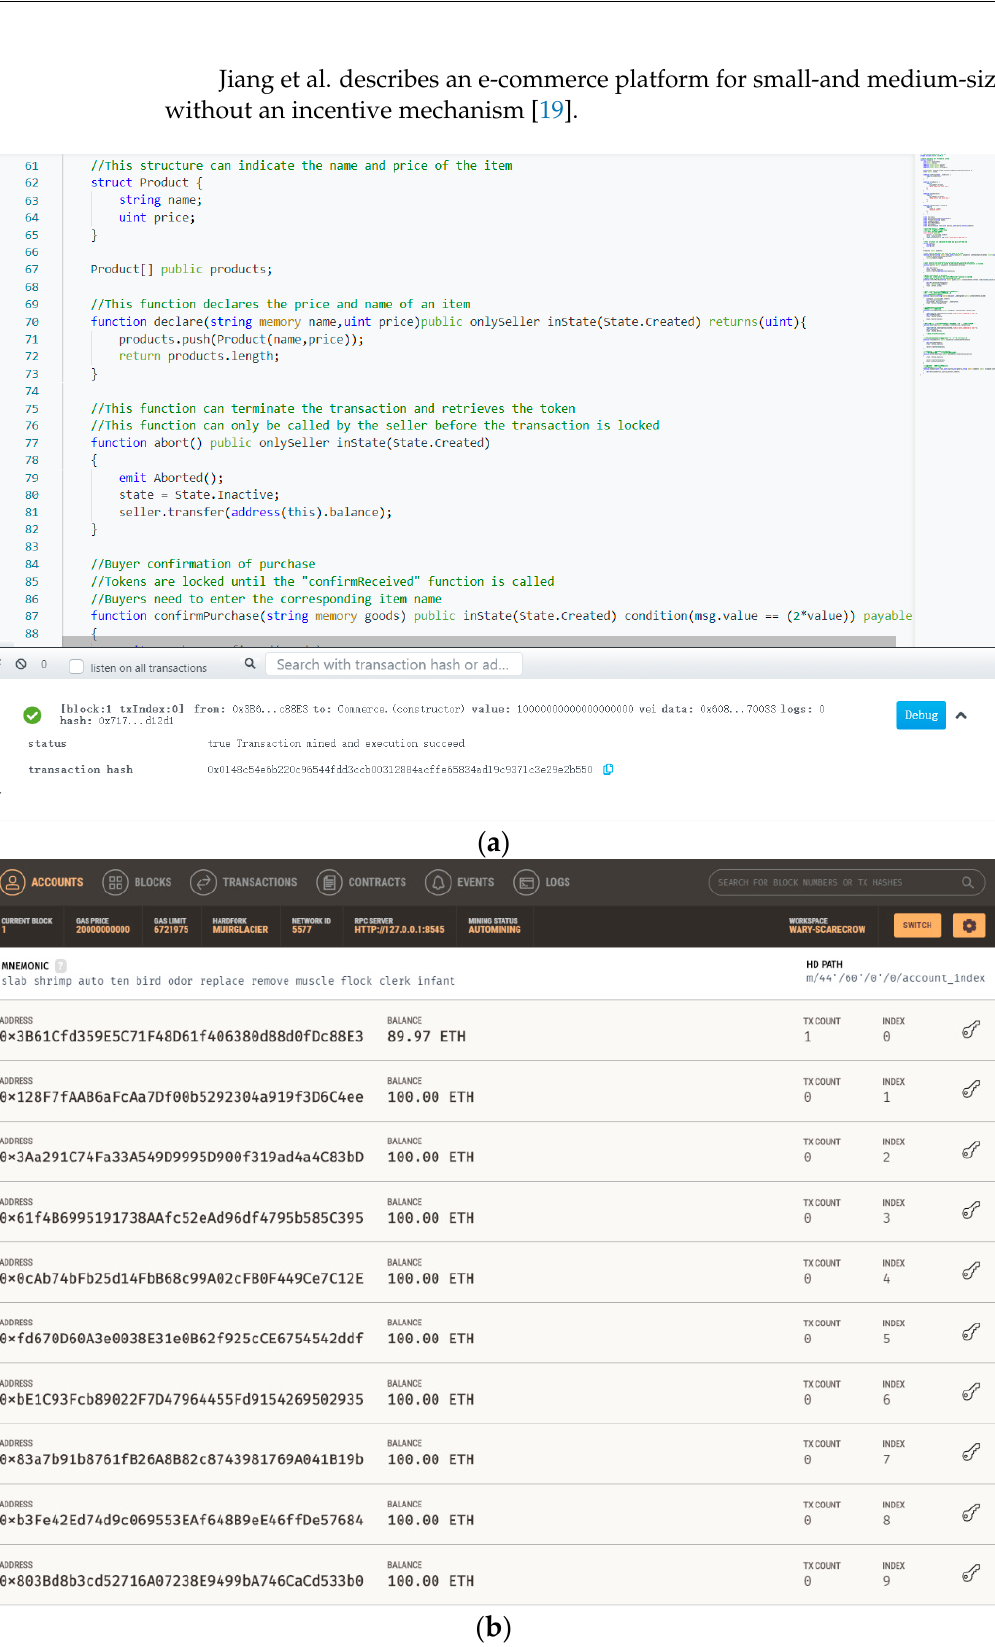
Figure 5. Smart contract compilation and testing: ( a ) Smart contract compilation tests; ( b ) Ganache simulates account token changes.